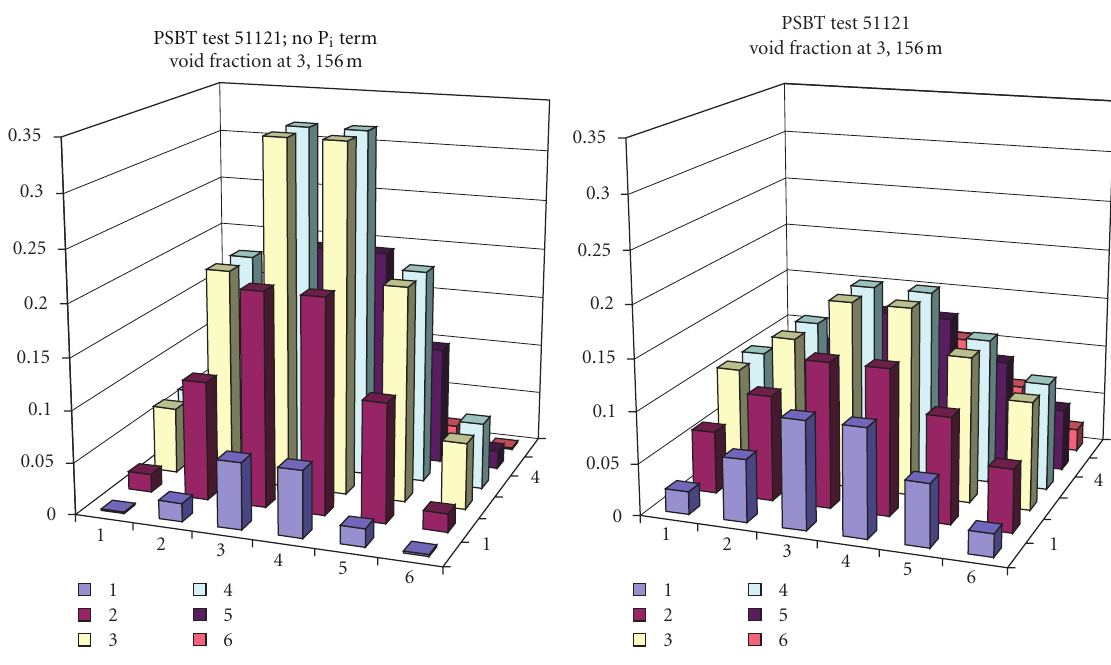
Figure 5: Sensitivity to the void di ff usion term.